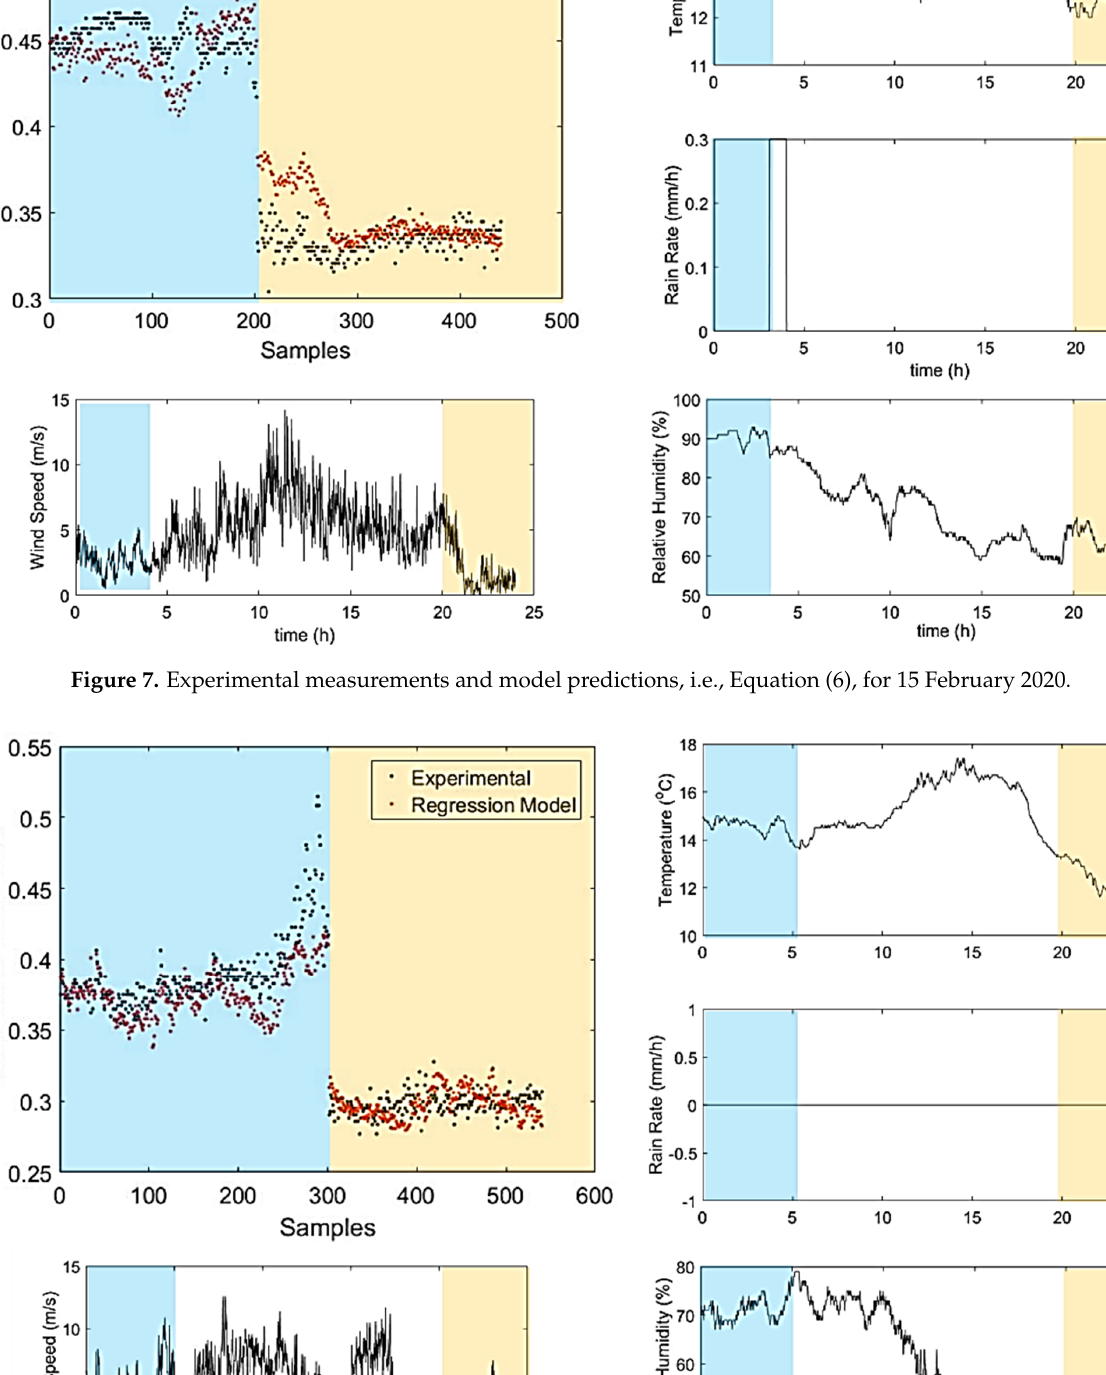
Table 5. R 2 values for several days.